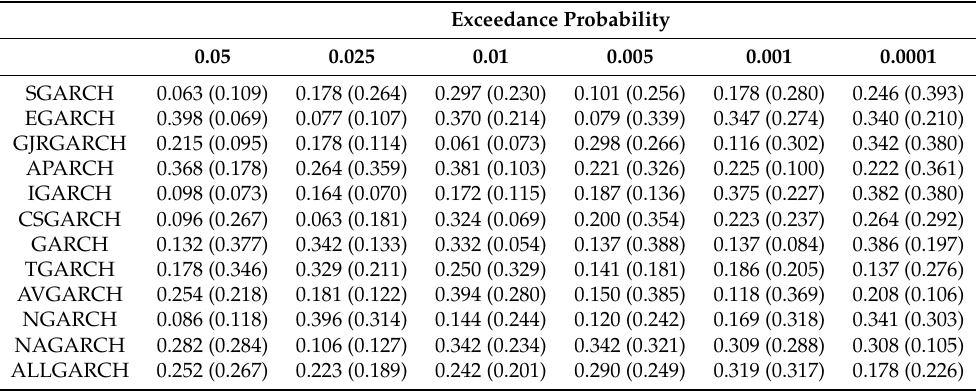
Table 4. p -values of the unconditional (conditional) coverage value at risk exceedance test for the log returns of the exchange rates of Dogecoin from 22 June 2014–17 May 2017.